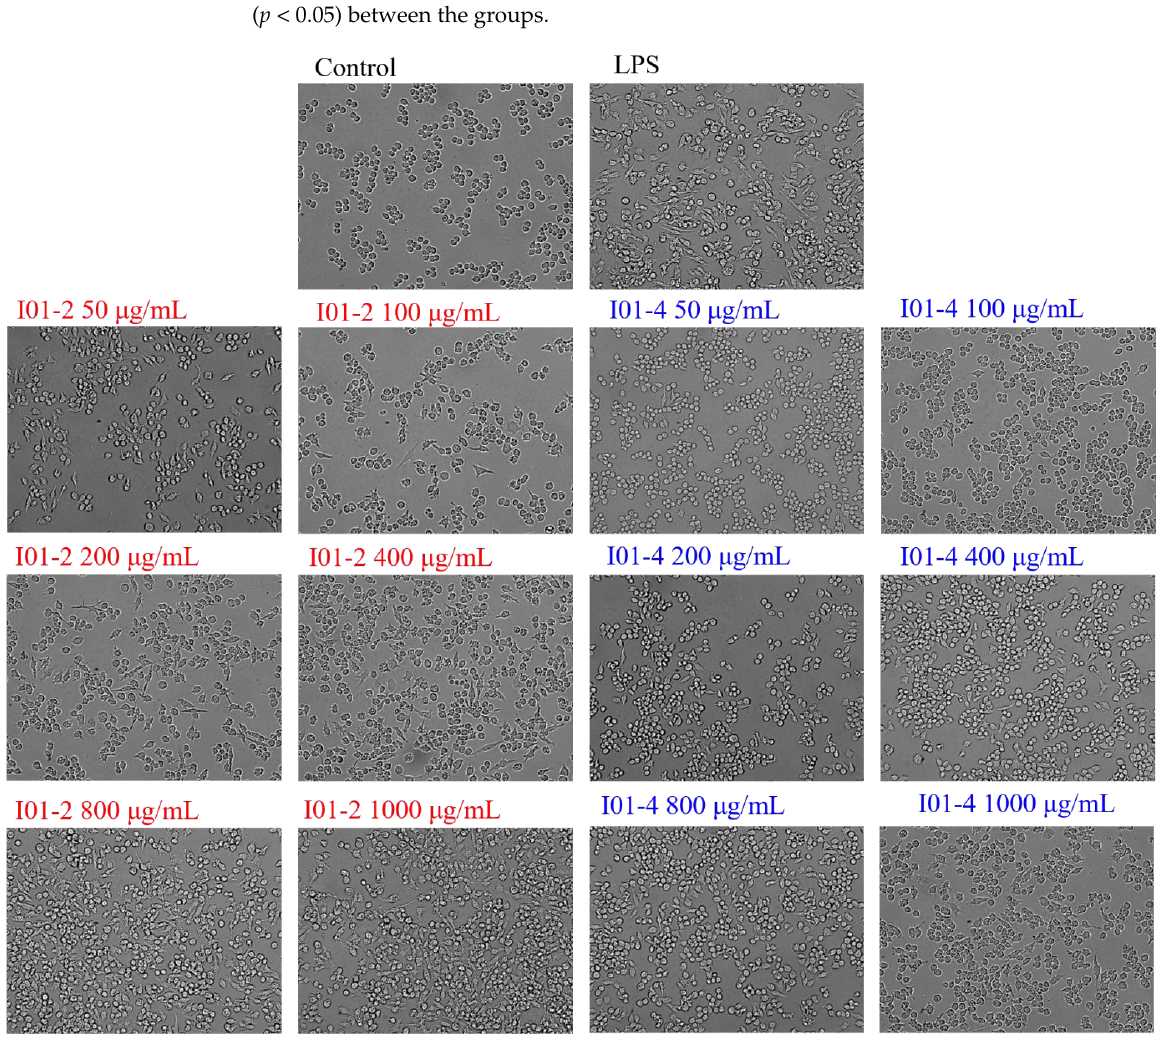
Figure 6. The effect of I01-2 and I01-4 on the morphology of RAW264.7